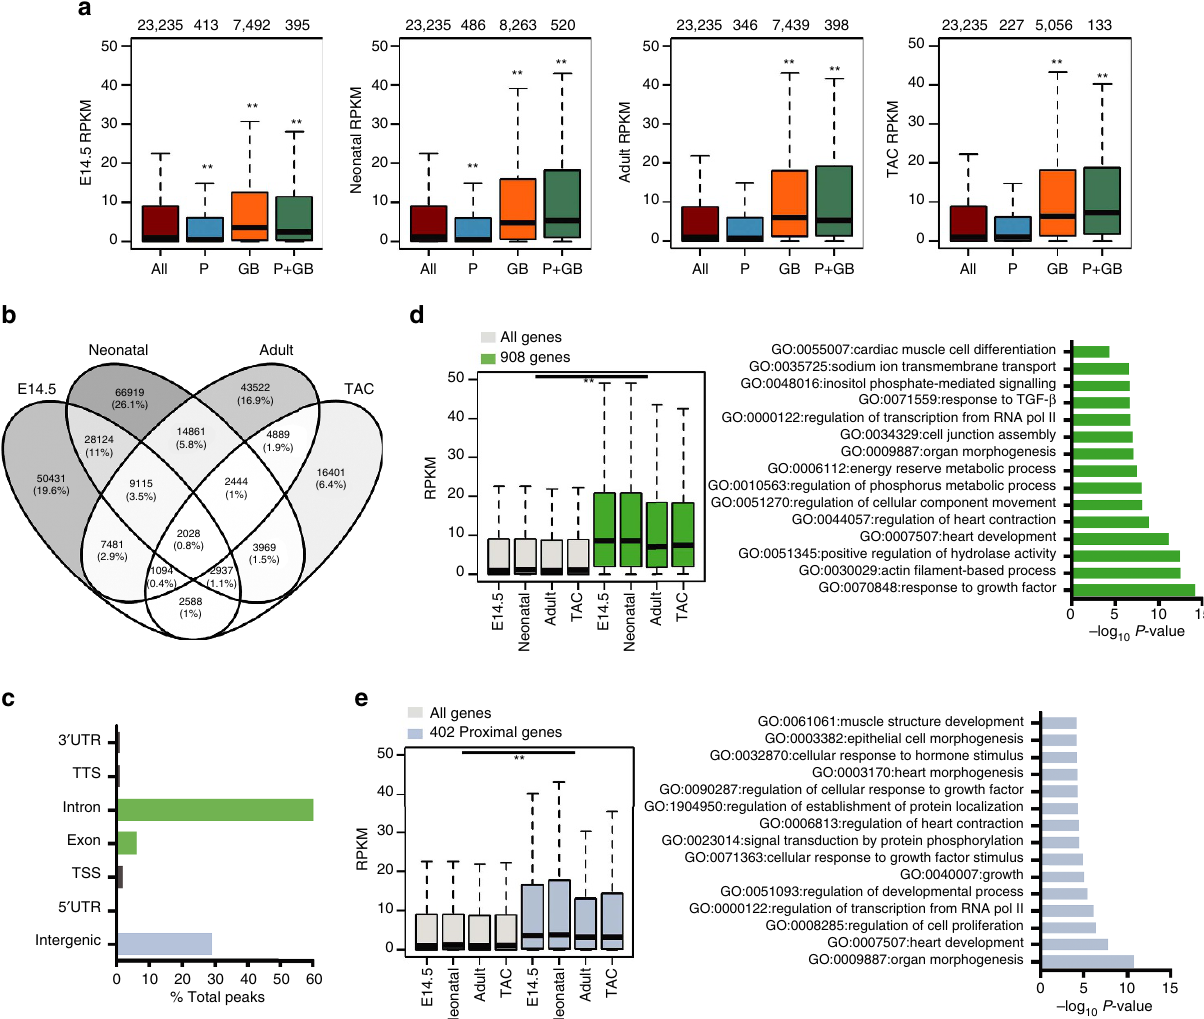
Figure 3 | Correlation of 5-hydroxymethylcytosine and gene expression. ( a ) Boxplots of RNA expression (RPKM) of all genes (brown bars), genes with 5-hmC exclusively present at promoters (P, blue bars), genes with 5-hmC exclusively on the GB (orange bars) and genes with 5-hmC at the promoter and on the GB (P þ GB, green bars). Thick lines indicate the median, with whiskers extending to ± 1.5 of the interquartile range. The number of genes in each group is shown above the plots. ** P -value r 0.01 (Mann–Whitney test). RPKM, reads per kilobase per million mapped reads. Promoters were defined as (cid:2) 1kb to þ 1kb relative to the TSS. ( b ) Venn diagram showing the number of common 5hmC-enriched intervals (peaks) across the four studied points, identified with bedtools multinter tool. ( c ) The presence of the 5-hmC peaks overlapping all four studied points ( n ¼ 2,028) at different genomic elements. TSS, transcription start site; TTS, transcription termination site; UTR, untranslated region. ( d ) Boxplots of RNA expression (RPKM) of the 908 genes with at least one peak on the GB (exons plus introns) at all studied points (left). Thick lines indicate the median, with whiskers extending to ± 1.5 of the interquartile range. ** P -value r 0.01 (Mann–Whitney test). RPKM, reads per kilobase per million mapped reads. Enriched GO terms relative to the 908 genes (right). GO analysis was assessed with Metascape 1.0 ( P -value r 0.01). ( e ) Boxplots of RNA expression (RPKM) of the 402 genes with at least one peak overlapping all the studied points proximal to the TSS (intergenic) (left). Thick lines indicate the median, with whiskers extending to ± 1.5 of the interquartile range. ** P -value r 0.01 (Mann–Whitney test). RPKM, reads per kilobase per million mapped reads. Enriched GO terms relative to the 402 genes (right). GO analysis was assessed with Metascape 1.0 ( P -value r 0.01). (Supplementary Fig. 7b); among these were 270 cardiac-specific with the downregulation of 737 genes (including 276 cardiac- genes (Supplementary Fig. 7c). Loss of 5-hmC was instead specific ones) involved in heart development, angiogenesis and associated with downregulation of 191 genes (54 of which were cell adhesion (Supplementary Fig. 7a,d). cardiac specific) that were enriched for biological processes In contrast, hypertrophy was associated with pronounced loss related to tissue morphogenesis, embryonic development and of 5-hmC on intragenic elements and a marked gain on intergenic Wnt signalling (Supplementary Fig. 7a,c). regions (Fig. 4g): despite the large overall loss of intragenic Further gain of 5-hmC on intragenic elements occurred in the hydroxymethylated DNA in hypertrophic CMCs, the modifica- neonatal-to-adult transition (Fig. 4f): these DhMRs were found tion was gained by a set of 40 upregulated heart-specific genes on 959 upregulated genes (193 of which were cardiac specific; (Supplementary Fig. 7e) among a total of 136 genes involved Supplementary Fig. 7d) enriched for energetic and metabolic mainly in extracellular matrix organization and actin cytoskeleton pathways (Supplementary Fig. 7b). Loss of 5-hmC was associated organization (Supplementary Fig. 7b), two important processes NATURE COMMUNICATIONS|7:12418|DOI: